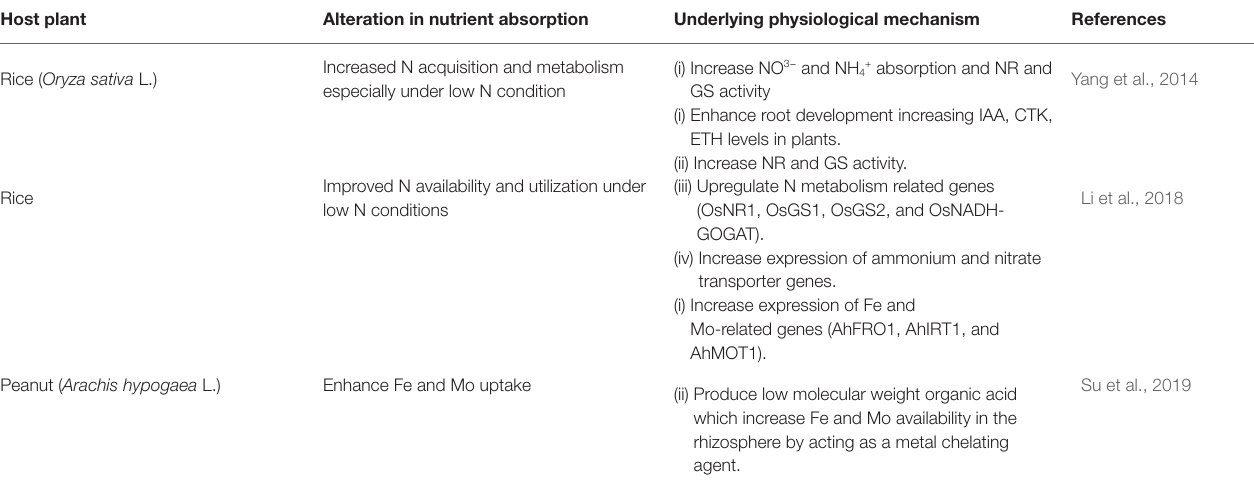
TABLE 2 | Different mechanisms employed by Phomopsis liquidambari for increasing nutrient uptake in plants. Host plant